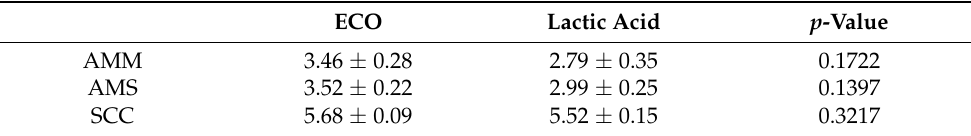
Table 3. Aerobic mesophilic bacterial count for milk (AMM) and swab (AMS), and the somatic cell count (SCC) after ECO treatment. Data in log10/mL.